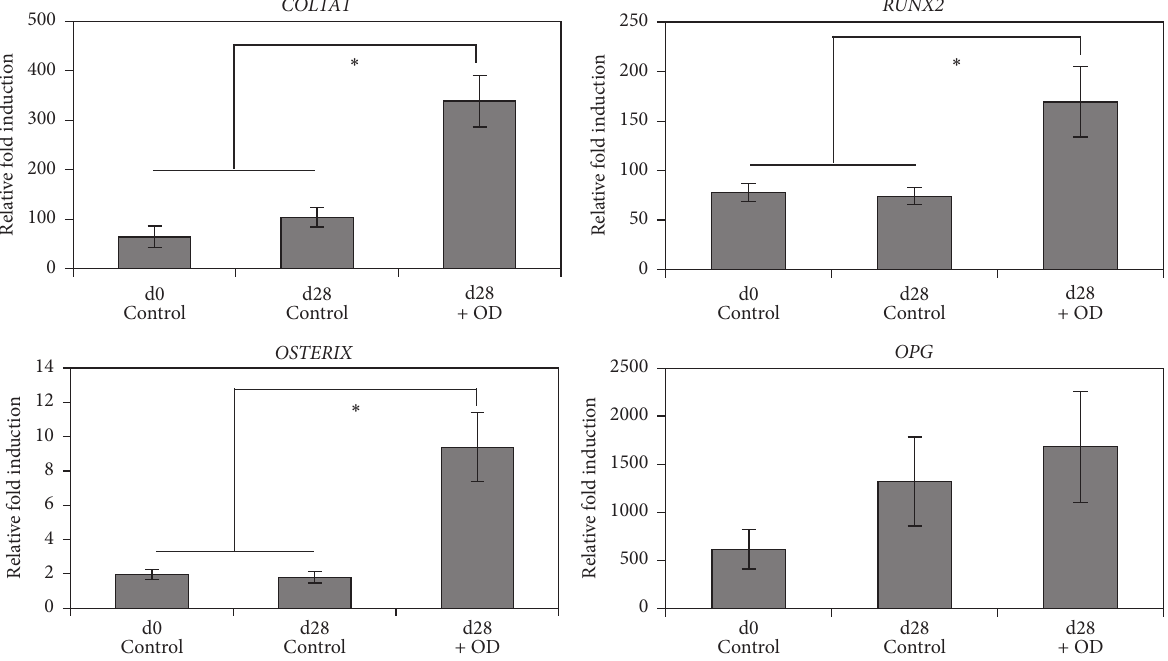
Figure 4: Characterization of osteogenic differentiation of hESC-OPs (GFP+) by real-time RT-PCR. The transcript levels were normalized to respective 𝛽 - Actin levels and to hESC (GFP+) cells. Values represent the means ± SD of three experiments ( ∗ 𝑝 < 0.05 versus respective controls). hESC-OPs (GFP+) were differentiated for 4 weeks in the presence of osteogenic factors (OD). Day 0 hESC-OPs (GFP+) and cells differentiated for 4 weeks without osteogenic factors were used as controls.